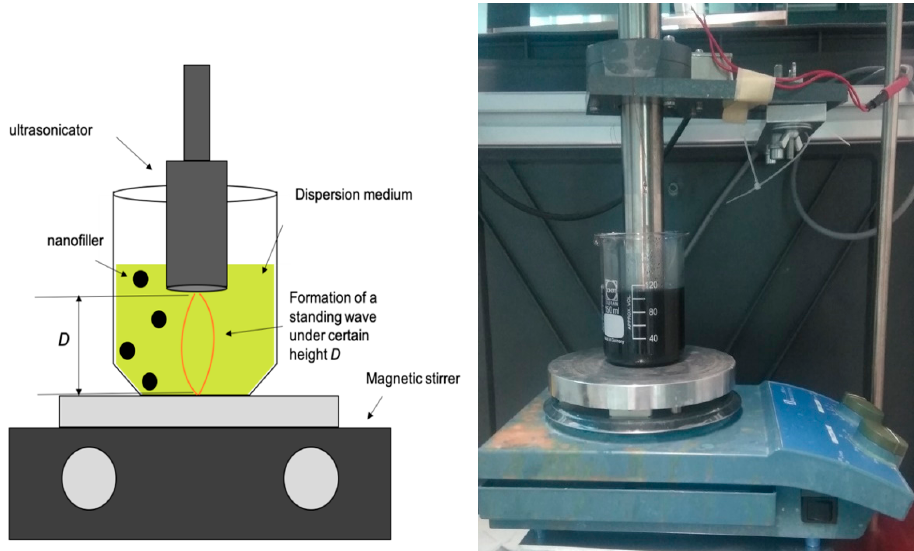
Figure 1. Schematic experimental setup of the ultrasonic dispersion experiments.